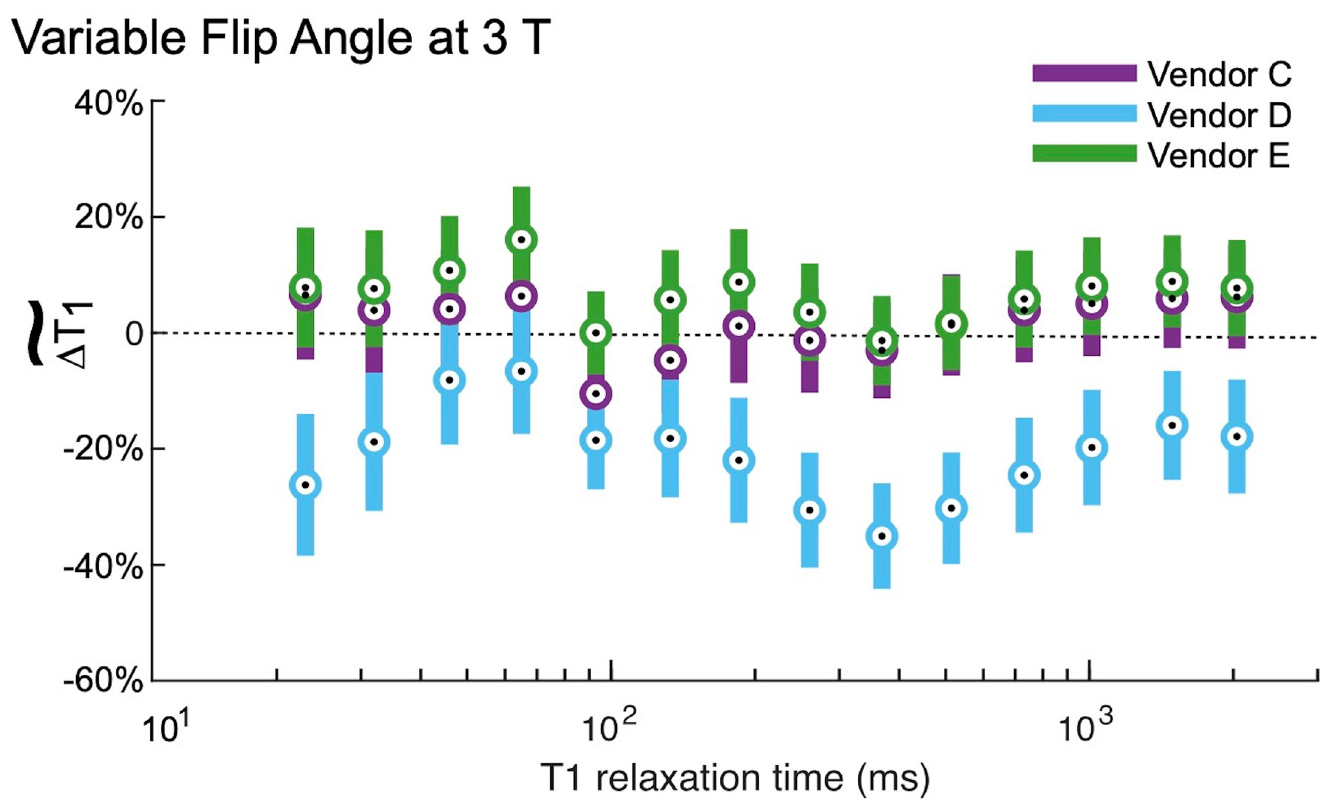
Fig 5. Variable flip angle measurements at 3 T. At 3 T, the variable flip angle (VFA) measurements had a much broader range of deviations than the IR measurements (Fig 3). The circles represent the within group means, and the error bars are 95% confidence intervals about these means. Vendors C and D and D and E are significantly (95% CI) different for many spheres; p-values are given in Table 5. Vendors C and E generally overestimated the T 1,NMR , while vendor D underestimated it. Finally, we observe a pattern in the vendor D deviation: The greatest deviation (largest underestimation) is for samples with T 1 relaxation times 260 ms, 368 ms, 514 ms, which are located in the “chin” of the phantom (Fig 1, sample spheres 5–7).